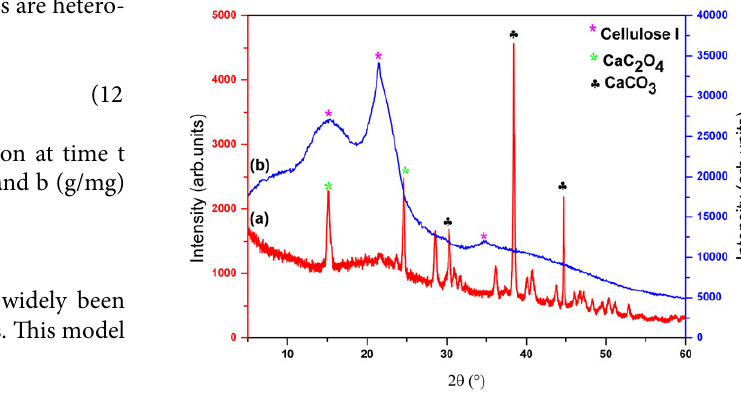
Fig. 1. XRD patterns of OFIP (a) and Ac-OFIP